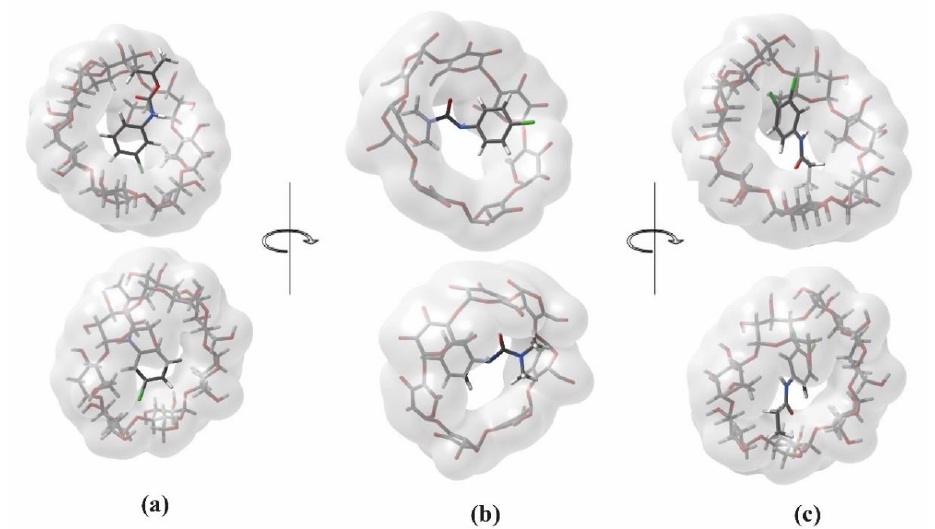
Figure 6. Molecular docking models of ( a ) Chlorpropham, ( b ) Monuron, and ( c ) Propanil in complex with the β -CD.